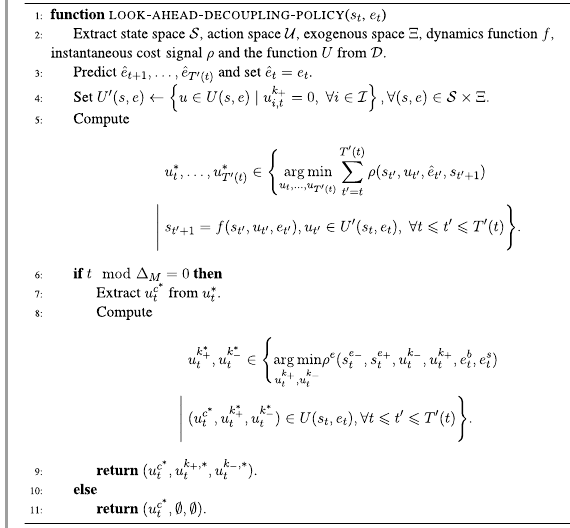
Algorithm 4. Look-ahead-decoupling policy for decision process D and policy horizon K